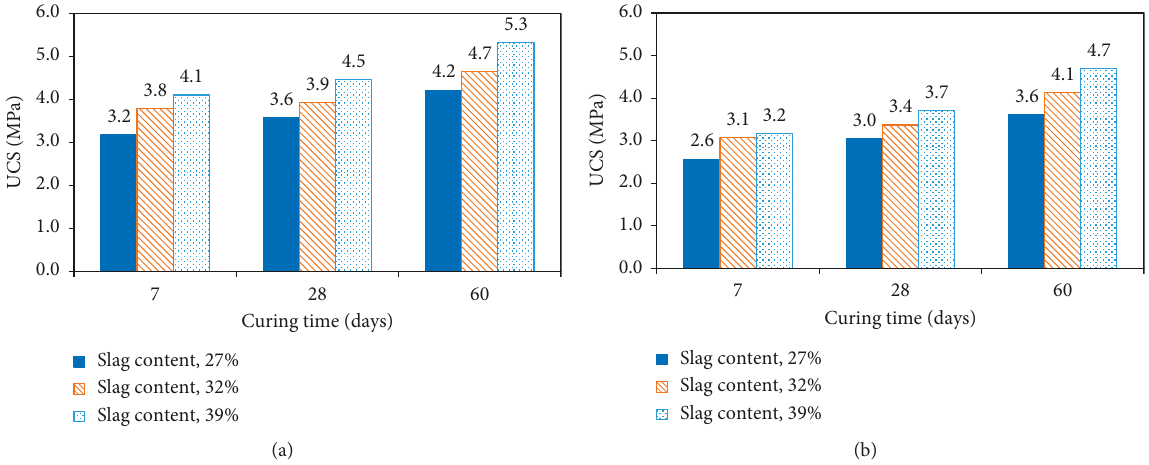
Figure 6: Unconfined compressive strength results for CTB. (a) Unconditioned set. (b) Conditioned set.